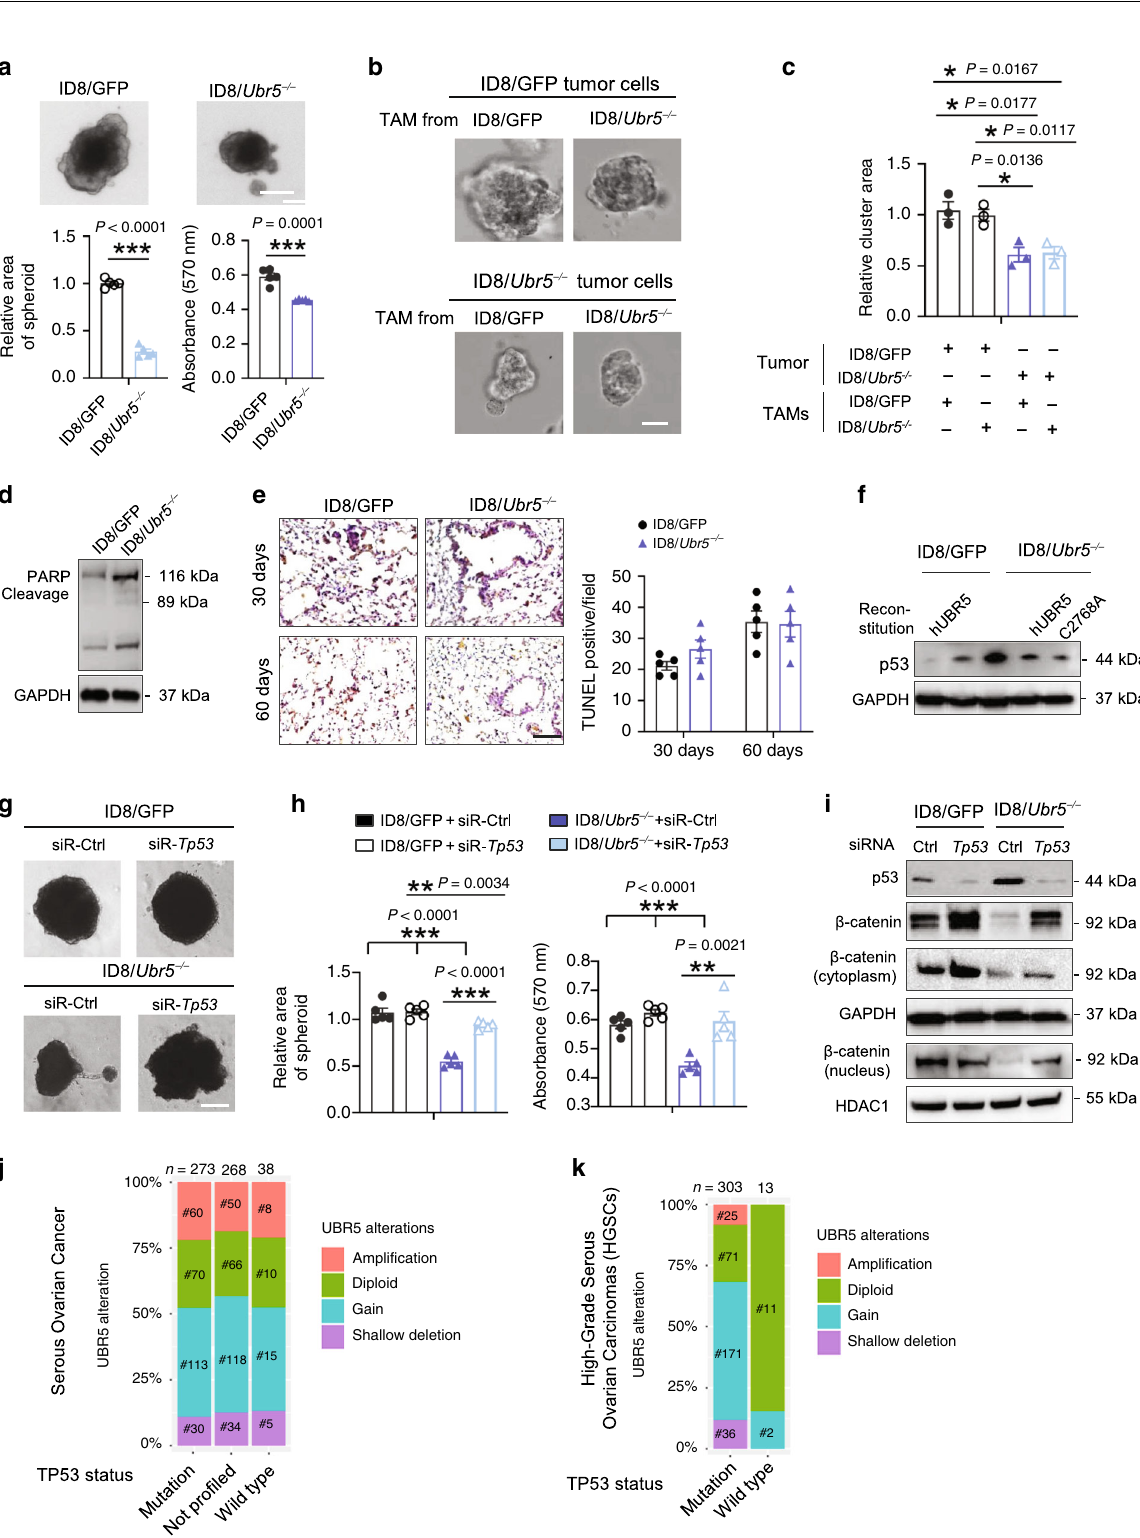
in both 2D and 3D cultures (Fig. 5g, h and Supplementary Fig. 7c), suggesting that UBR5 promotes OC progression at least in part by regulating the level of p53. It is noteworthy that knocking down p53 expression in ID8/ Ubr5 − / − cells restored β - catenin to the control level associated with more nuclear accumulation, which is indicative of enhanced transcriptional activity of β -catenin (Fig. 5i, and Supplementary Fig.